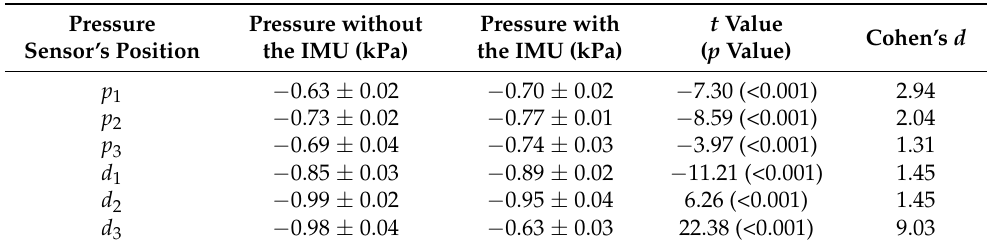
Table 2. Comparison of pressure on hand model between cases with and without the IMU based on 0 ◦ and 1.6 m · s − 1 .